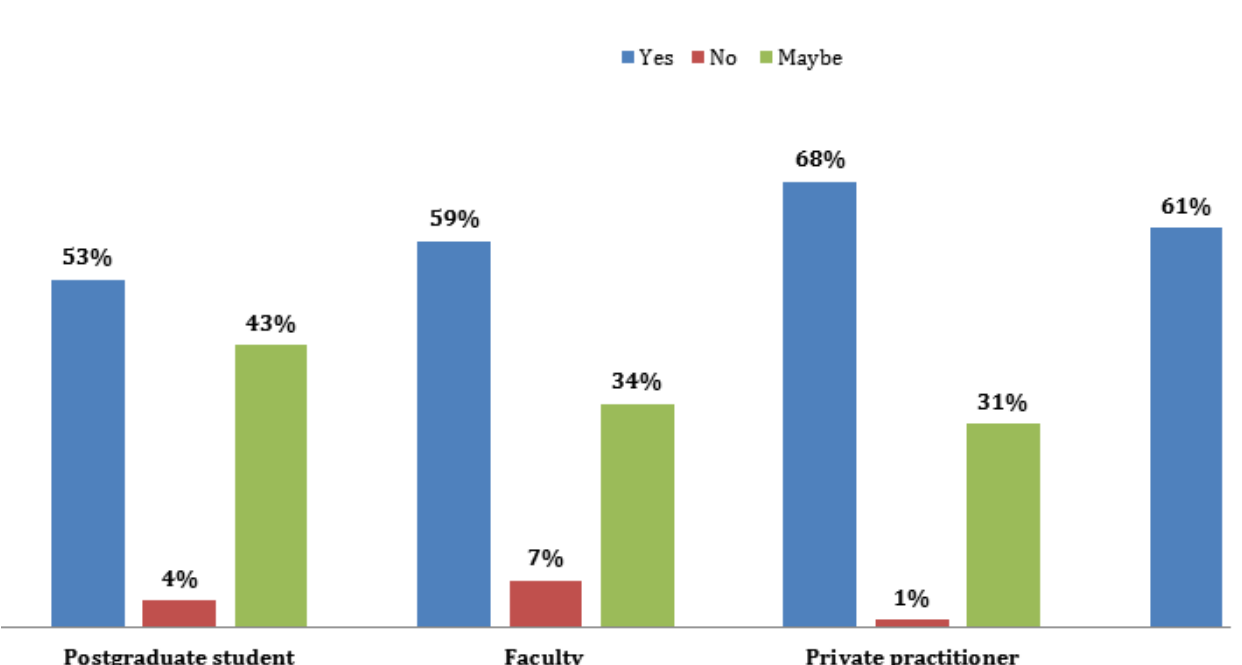
Figure 2. R esponses for the question on their perception of sufficient knowledge on COVID-19.